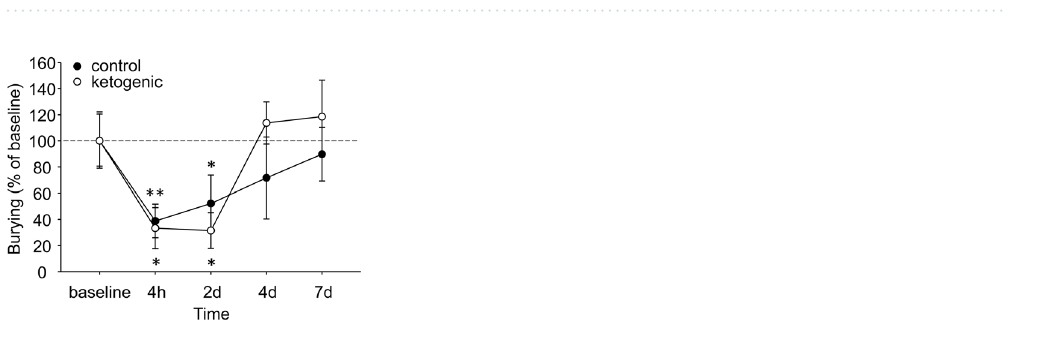
Figure 6. Effects of ongoing pain and dietary treatment on marble burying in mice. CFA injection reduced marble burying in all mice, with no effect of dietary treatment. Control n = 5, ketogenic n = 7. **p < 0.01, *p < 0.05 compared to